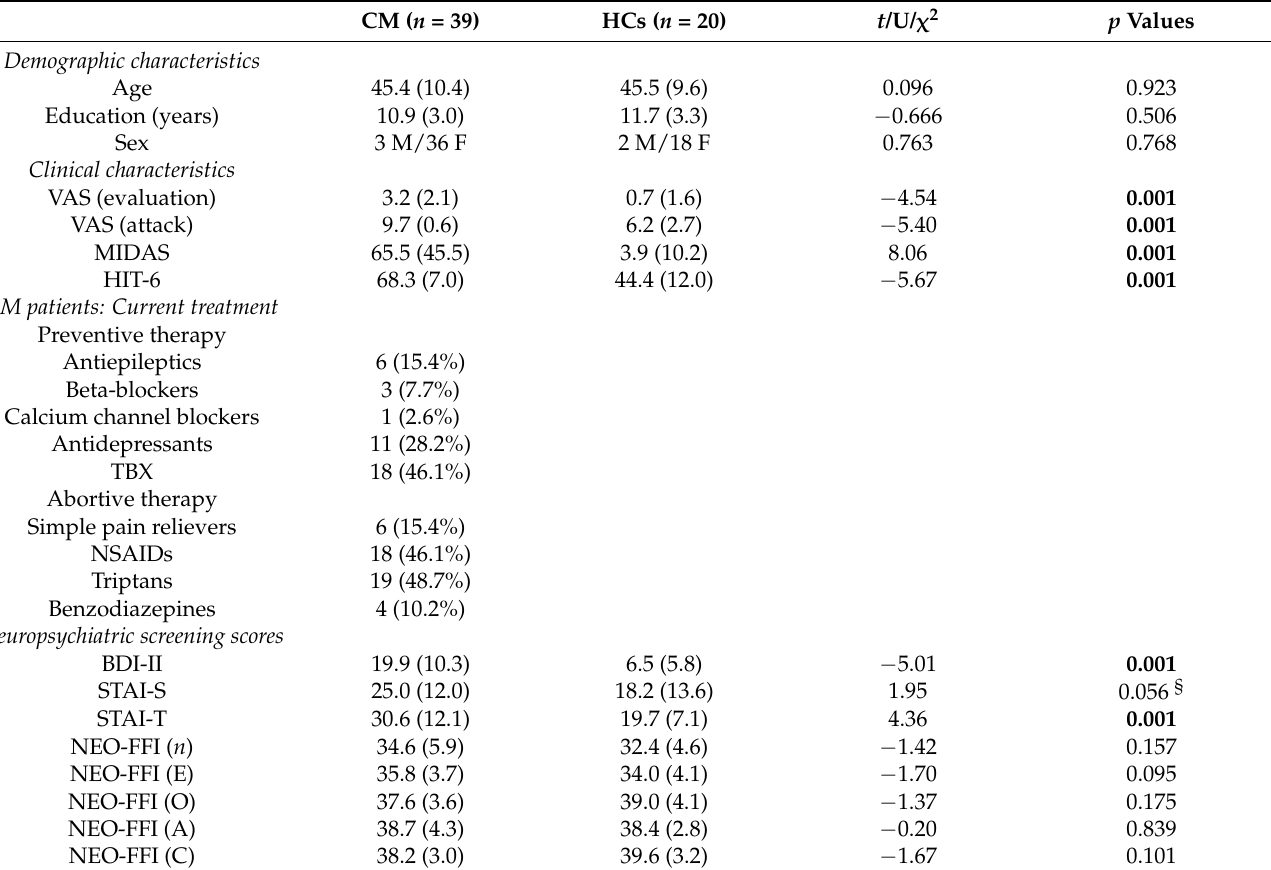
Table 1. Demographic, clinical, and neuropsychiatric characteristics of CM